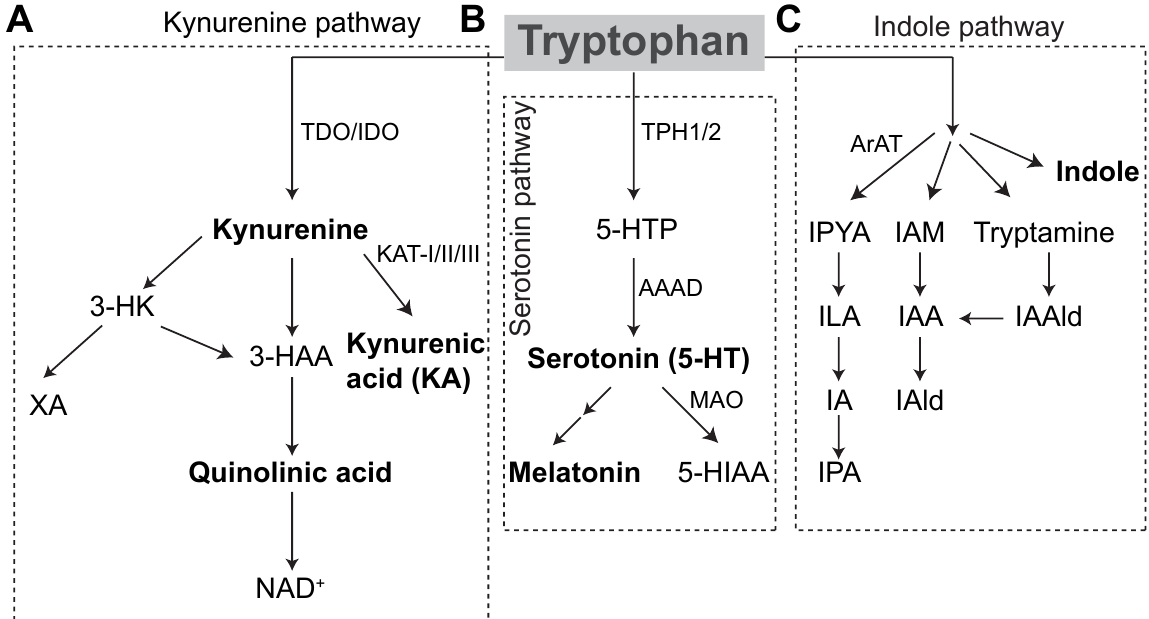
Figure 1. Tryptophan Metabolic Pathways. Tryptophan metabolism in hosts occurs via the kynurenine pathway or the serotonin pathway to produce bioactive metabolites. ( A ) 90% of kynurenine pathway degradation occurs in the liver via TDO conversion of TPH to kynurenine. The remaining kynurenine degradation occurs by IDO in the brain, GI tract and liver. Kynurenine is metabolized to kynurenic acid by KAT enzymes. It can also be metabolized to quino- linic acid, which is then converted to NAD + . Alternatively, kynurenine is converted to 3-HK and subsequently to XA. ( B ) In the serotonin pathway, TPH is converted to 5-HTP by TPH1 in enterochromaffin cells, or TPH2 in enteric or cen- tral neurons. 5-HTP is decarboxylated to form serotonin. Serotonin can be further metabolized to form melatonin, or degraded by MAO to 5-HIAA, which is excreted in the urine. ( C ) In gut microbes, tryptophan is metabolized into in- dole and indole derivatives. Microbes express different enzymes that utilize TPH. Conversion of TPH to IPA occurs initially through aromatic amino acid decarboxylase to IPYA, which is then converted to ILA and IA prior to conversion to IPA. Through other tryptophan-degrading enzymes, microbes can create metabolic end-products IAld and IAAld. IAAld, which is formed from tryptamine, can also be converted to IAA and subsequently to IAld. Microbes may also convert TPH directly to indole. AAAD = aromatic amino acid decarboxylase, ArAT = aromatic amino acid amino- transferase, 3-HAA = 3-hydroxyanthranilic acid, 5-HIAA = 5-hydroxyindoleacetic acid, 3-HK = 3-hydroxykynurenine, 5-HT = 5-hydroxytryptamine, 5-HTP = 5-hydroxytryptophan, IA = anholocyclic acid, IAA = indole-3-acetic acid, IAAld = indole-3-acetaldehyde, IAld = indole-3-aldehyde, IAM = indole-3-acetamide, IDO = indoleamine 2,3-dioxygenase, ILA = indole-3-lactic acid, IPA = indole-3-propionic acid, IPYA = indole-3-pyurvic acid, KAT = kynurenine aminotrans- ferase, MAO = monoamine oxidase, NAD = Nicotinamide adenine dinucleotide, TDO = tryptophan 2,3-dioxygenase, XA = xanthurenic